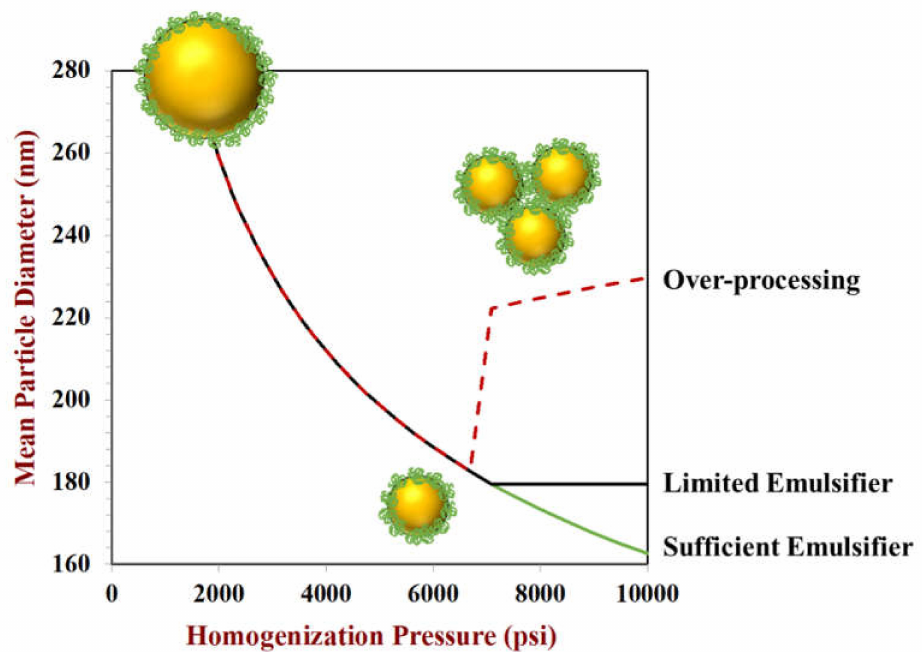
Figure 6. The mean particle diameter usually decreases with increasing homogenization pressure, provided there is sufficient emulsifier present to cover the surfaces of all droplet formed. In some situations, the particle size increases at high homogenization pressures, which is known as over- processing. Predictions were made using Equation (2) for the case of sufficient emulsifier, and modified for the other curves to schematically show the effects of over-processing and limited emulsifier on droplet